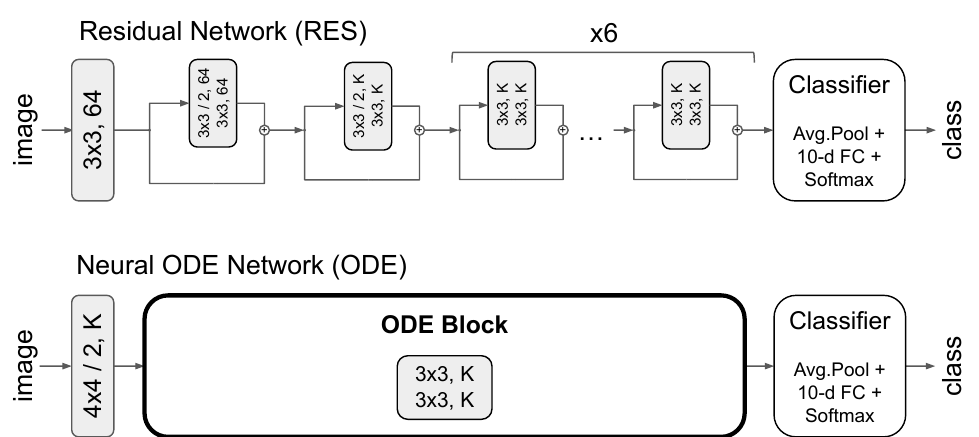
kernel height [/ stride], n. filters ; ×